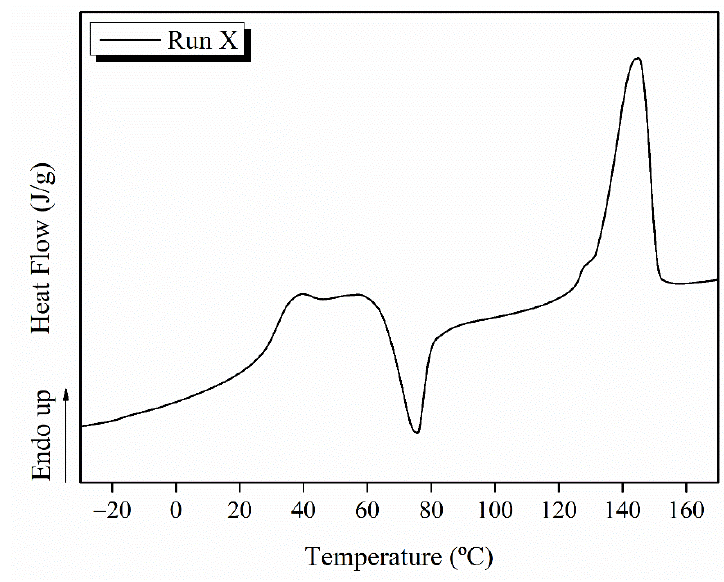
Figure 2. DSC thermogram for PLA-based efibers obtained in run X.